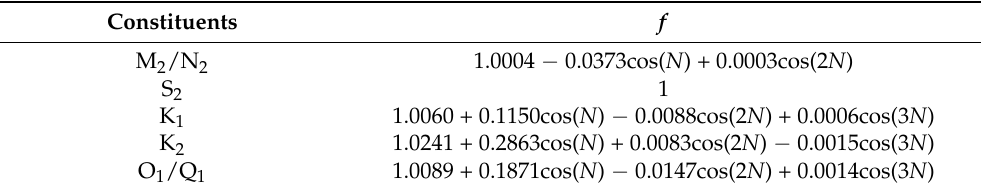
Table 1. Nodal factor f for the four major tidal constituents as derived from equilibrium tidal theory.